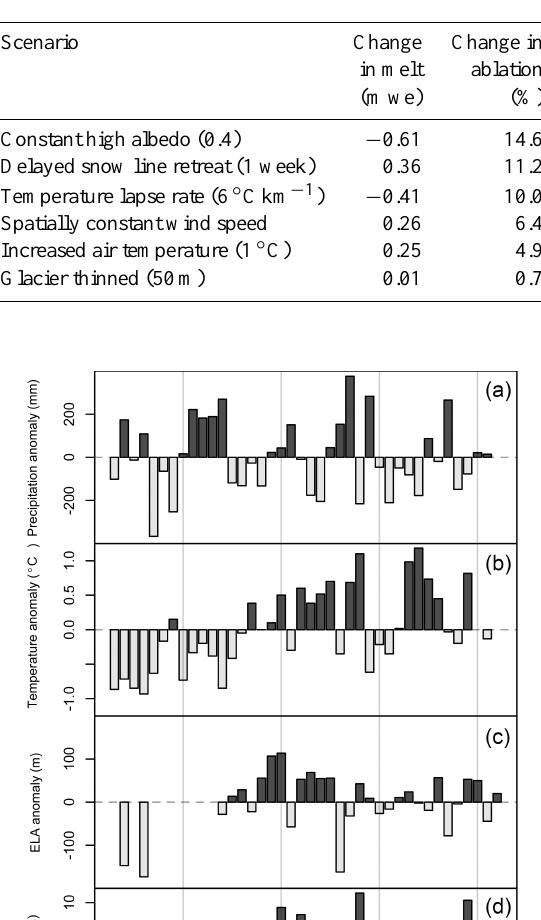
Table 1. Sensitivity of DEBM to various process parameterisations during the 2013 study period. All changes are relative to the em- ployed DEBM model, are calculated relative to all ablation below the ELA, and are spatially averaged over the ablation area.